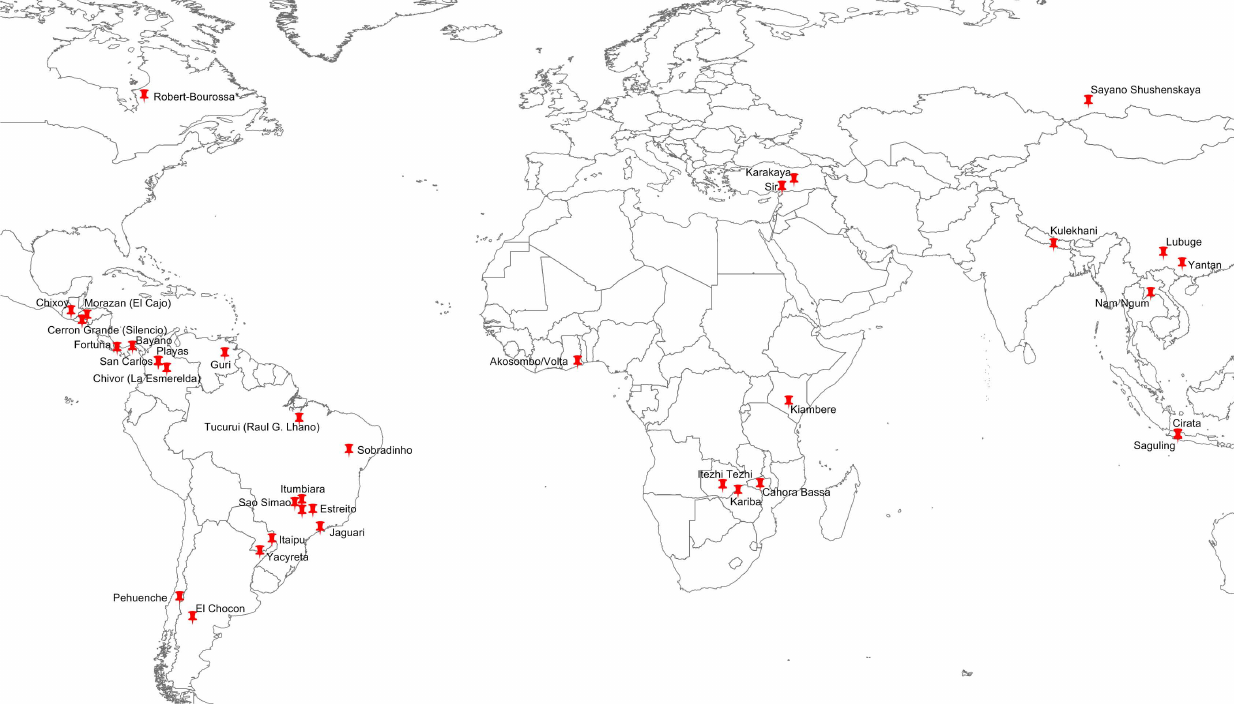
Fig. 1. Locations of the selected hydropower